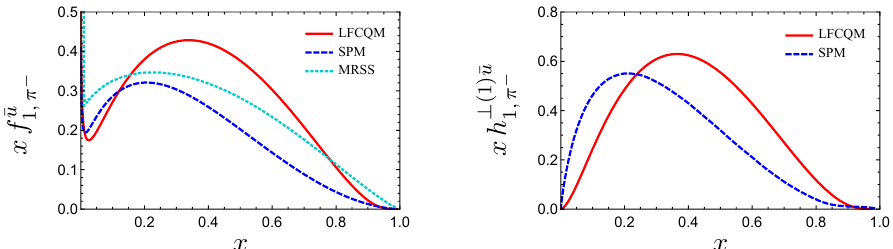
Figure 3 . Left: f (cid:22) u from LFCQM [59] and SPM [51] LO-evolved to the scale Q 0 in comparison 1 ;(cid:25) (cid:0) to MRSS parametrization [41]. Right: predictions from LFCQM [59] and SPM [51] for the pion Boer-Mulders function (with the sign for DY) for which no parametrizations are currently